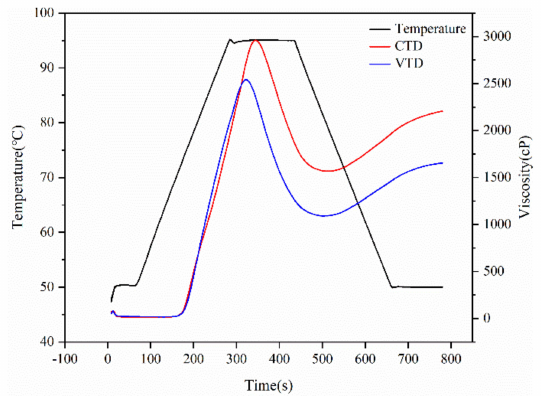
Figure 5. RVA profiles of two